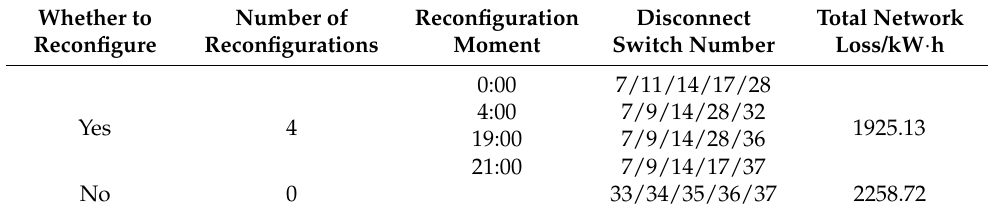
Table 8. Reconstruction